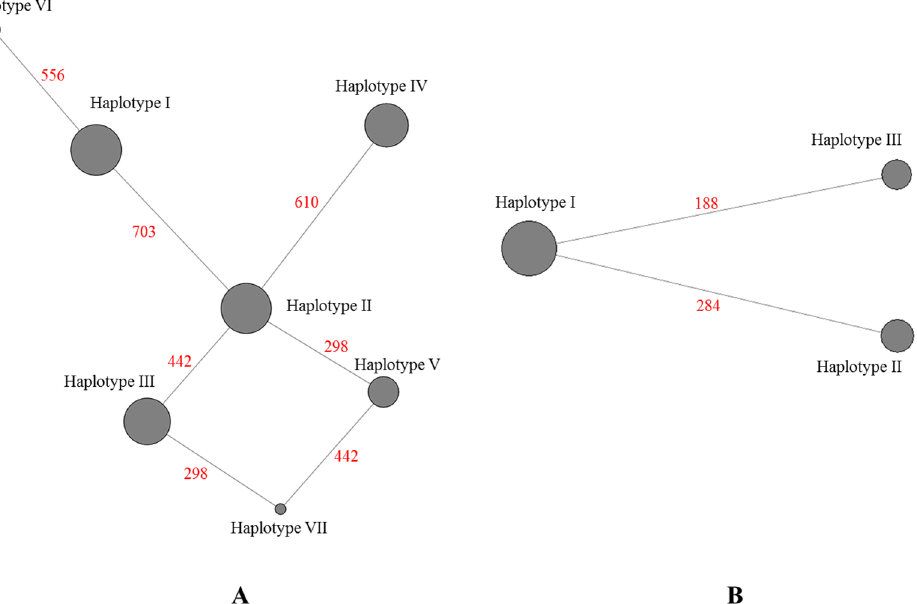
Fig 5. Median-joining network obtained with the haplotypes of all samples. A- Representation for the mtDNA CO1 sequences. B- Representation for mtDNA ND4 sequences. The diameters of grey circles represent the frequency of each haplotype for all individuals. The red number indicates the position of the mutation on the analyzed